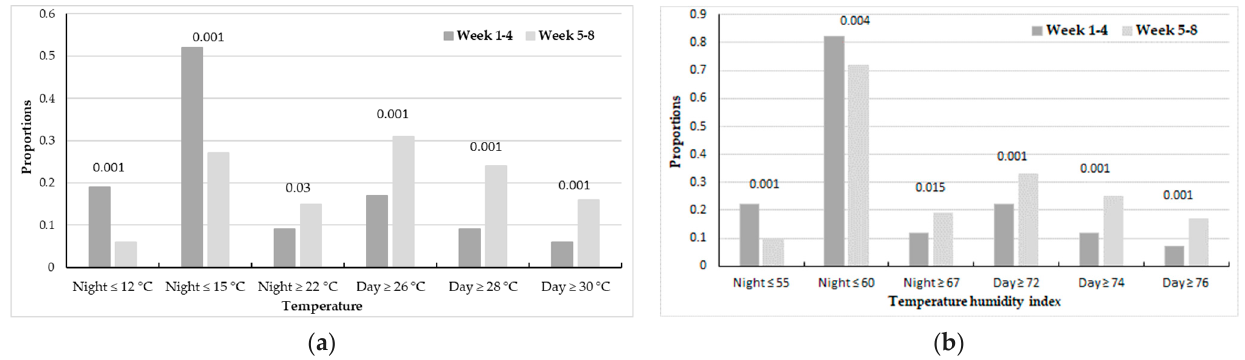
Figure 5. The proportions of night temperature hours below 12, 15 °C or above 22 °C and day temperature above 26, 28 or 30 °C ( a ) and the proportions of night THI hours below 55, 60 or above 67 and day THI above 72, 74 or 76 ( b ).